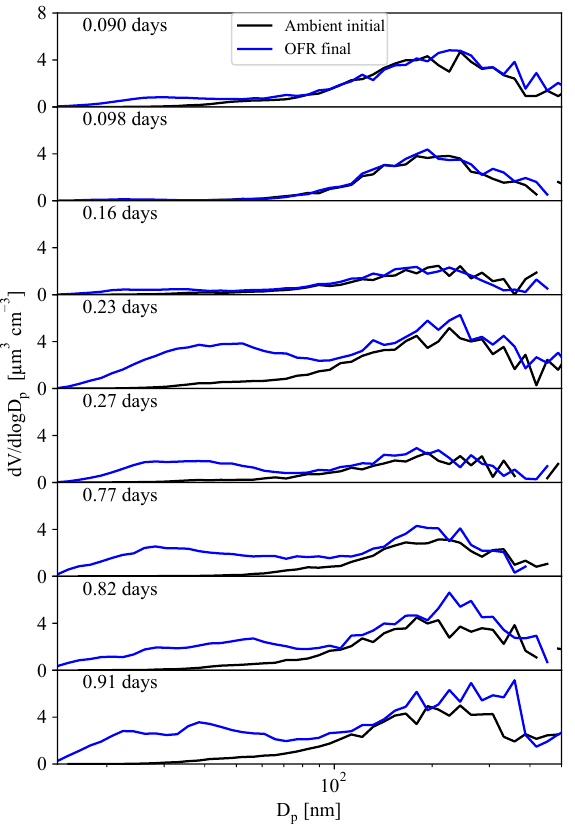
Figure 1. BEACHON-RoMBAS initial (i.e., ambient air, black line) and final (i.e., after OFR processing, blue line) SMPS-derived vol- ume distributions for each individual exposure modeled in this study. The differences in SOA production between exposures of similar ages are due to the fact that the exposures were taken from different times during the campaign and thus different precursor concentrations were present (Table 2).